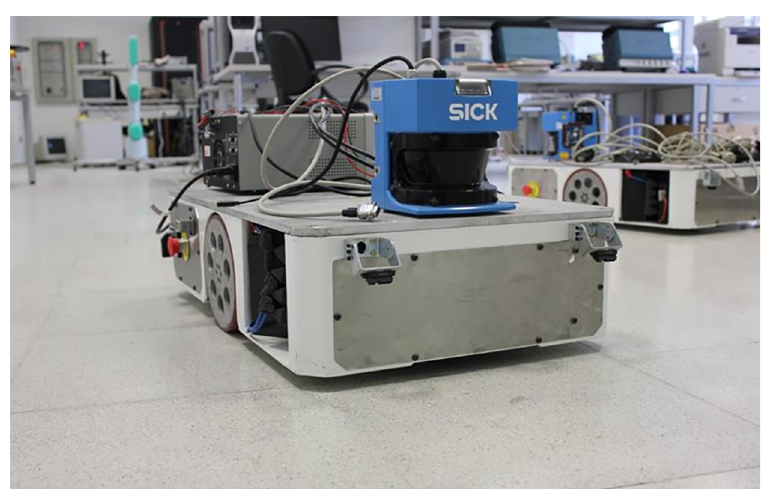
Fig 16. SICK-LMS511 laser range finder